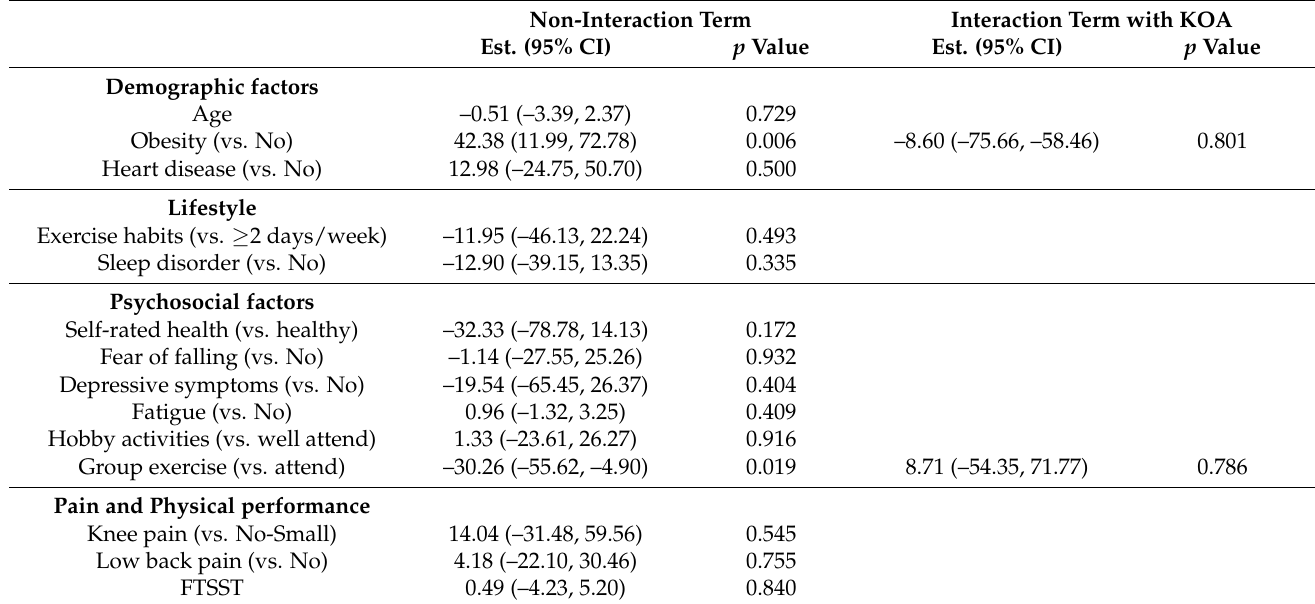
Table 3. Factors associated with passive sedentary behavior and interactions with knee osteoarthritis ( n =